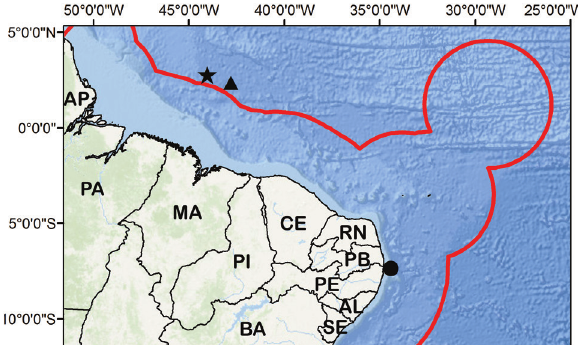
Figure 1. Northern portion of Brazil with indications for the type localities of Leptocephalus anaelisae (star), Leptocephalus juliae (dot), and Leptocephalus humbermariorum (triangle). Red line represents the boundaries of the Brazilian Economic Exclusive Zone. Abbrevia- tions stand for the Brazilian States: (AL) Alagoas, (AP) Amapá, (BA) Bahia, (CE) Ceará, (MA) Maranhão, (PA) Pará, (PB) Paraíba, (PE) Pernambuco, (PI) Piauí, (RN) Rio Grande do Norte, (SE)